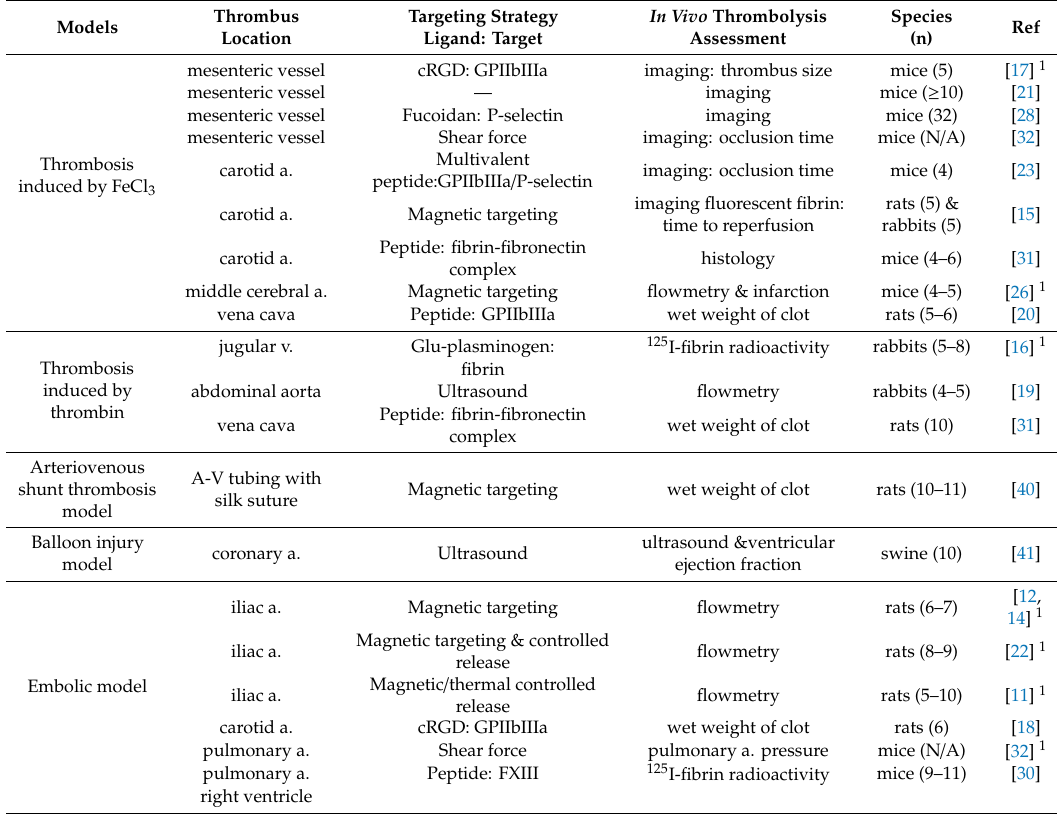
Table 1. Animal models used for evaluation of nanocomposite-induced target thrombolysis with statistical